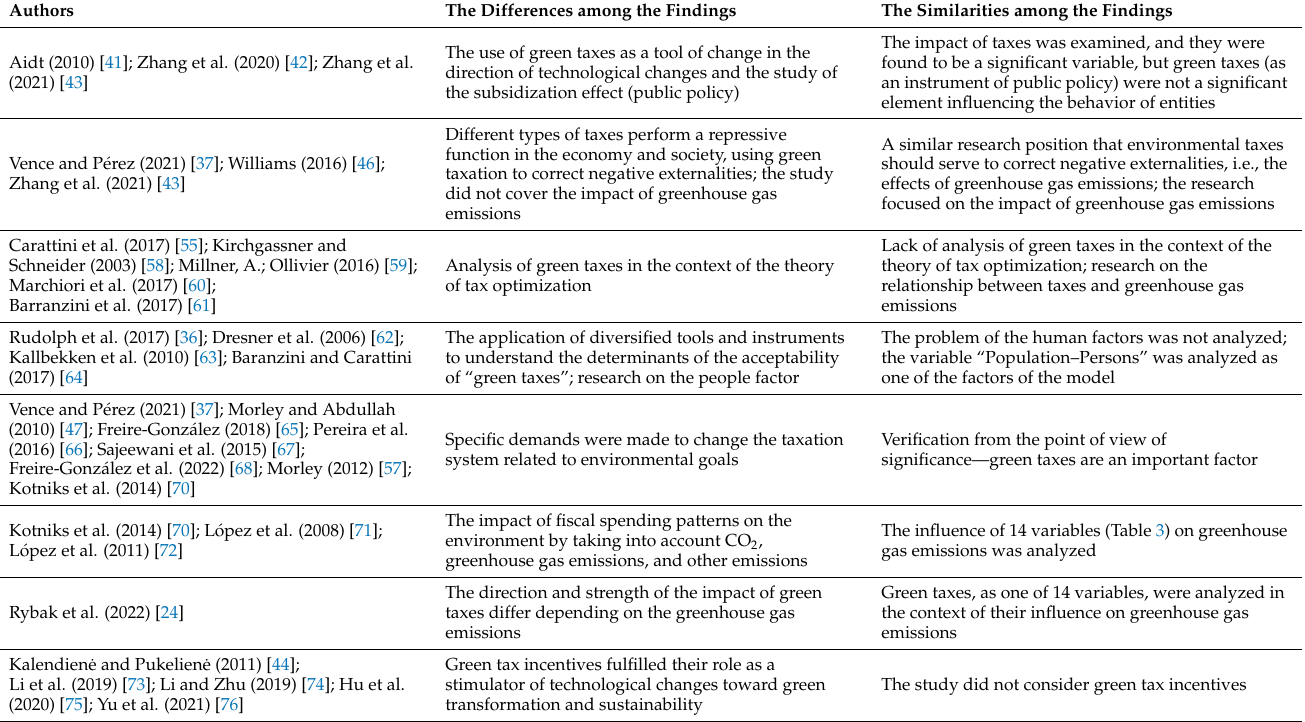
Table 13. The differences and similarities between the findings of the present study and those of other